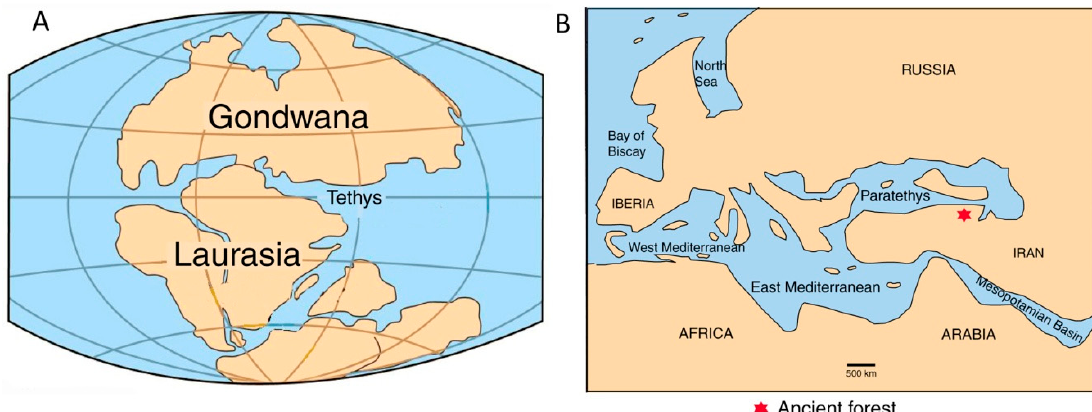
Figure 5. Paleogeographic setting of the Meshgin Shahr fossil forest. ( A ) During much of the Mesozoic, the Tethys seaway was located in the rift zone between Laurasia and Gondwana. ( B ) Early Cenozoic closure of the Tethys was followed by the development of the Paratethys. Generalized map from Late Miocene, 8.5–7.0 Ma, adapted from [4].